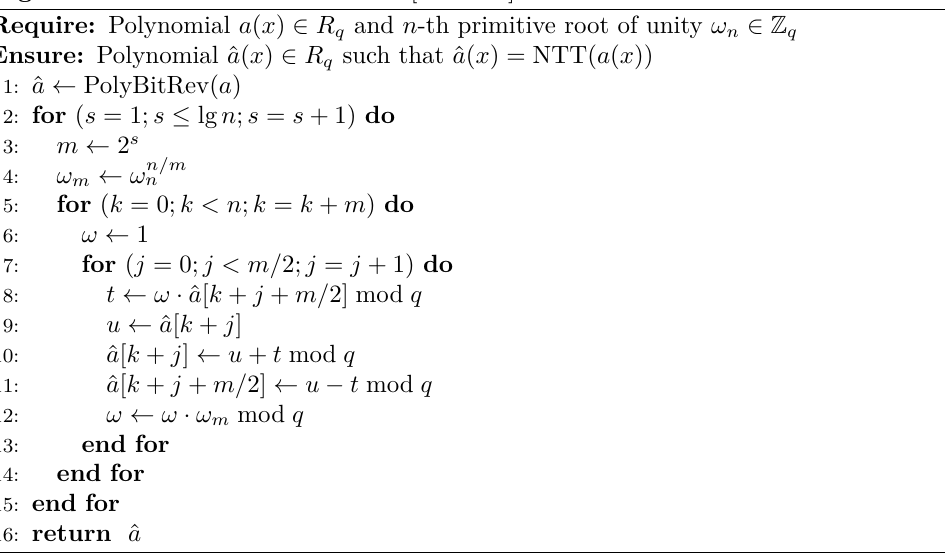
Algorithm 1 Iterative In-Place NTT